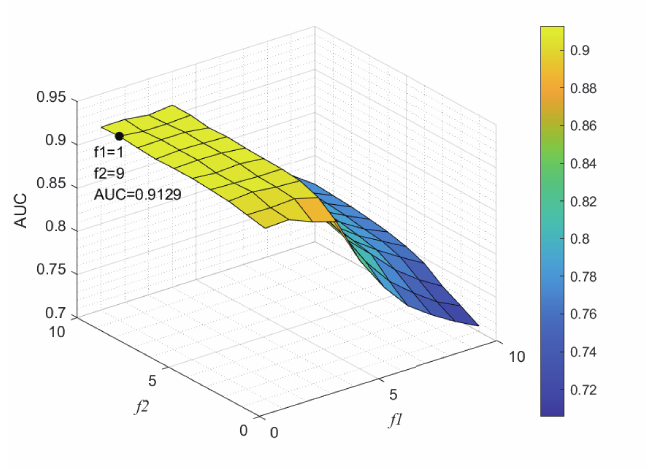
Figure 6. Sensitivity analysis of parameter f 1 and f 2 .